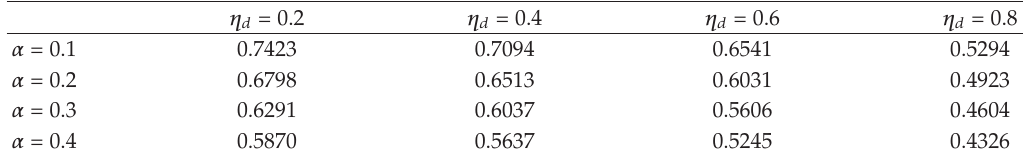
Table 3: Maximum allowable upper bounds h 2 of the uncertain Lur’e system with interval time-varying delay (cid:6) 4.3 (cid:7) for di ff erent values of the η d and decay rates.